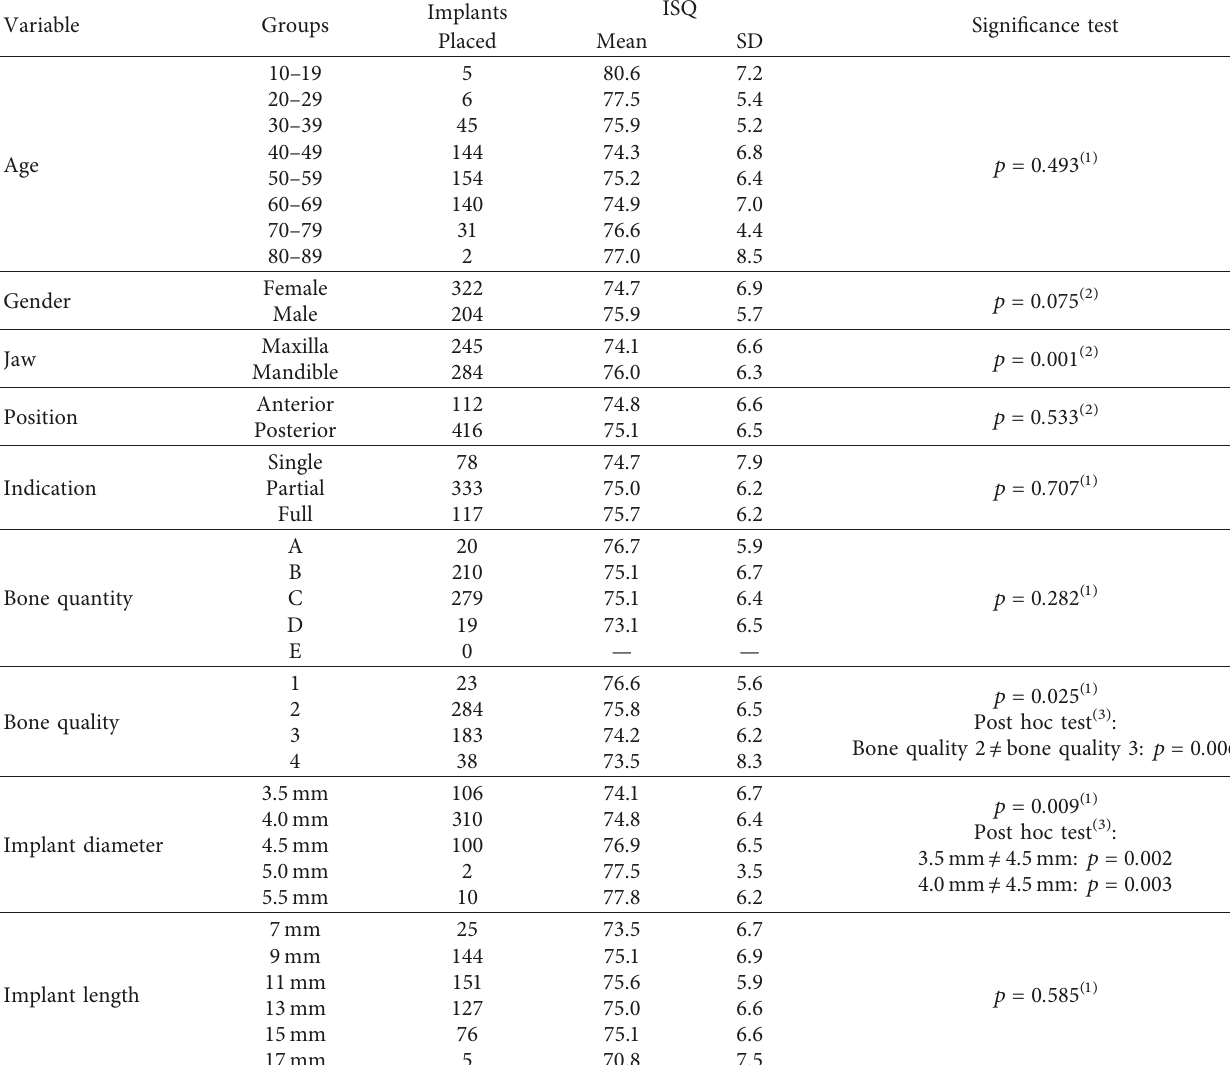
Table 8: Analyses of implant stability at abutment connection or prosthetic